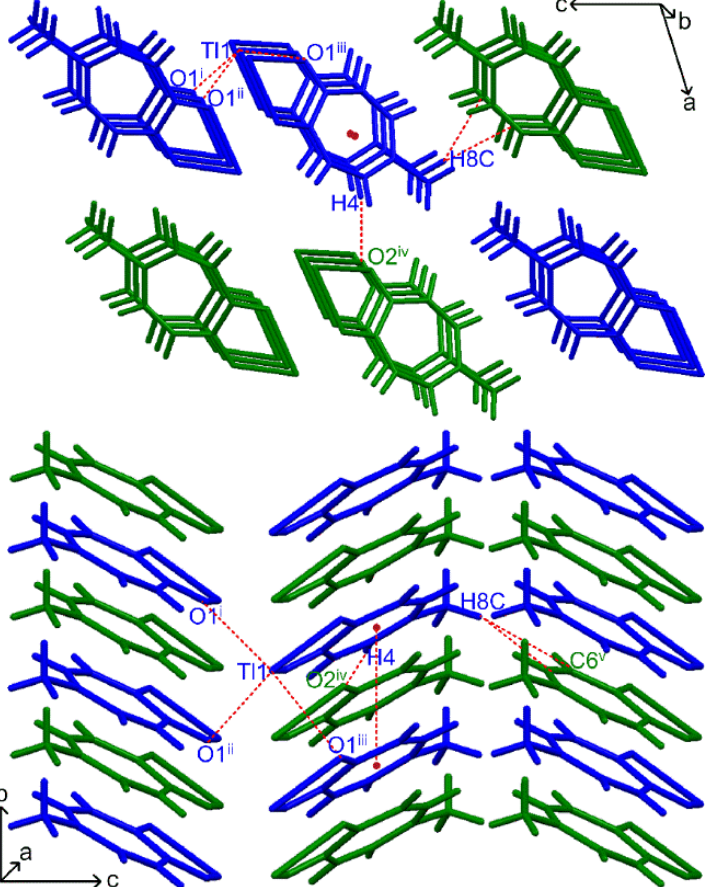
Figure 6. Two different views of the arrangement of Tl(5-metrop) chelates in the extended structure of 2 showing the chosen intermolecular contacts.